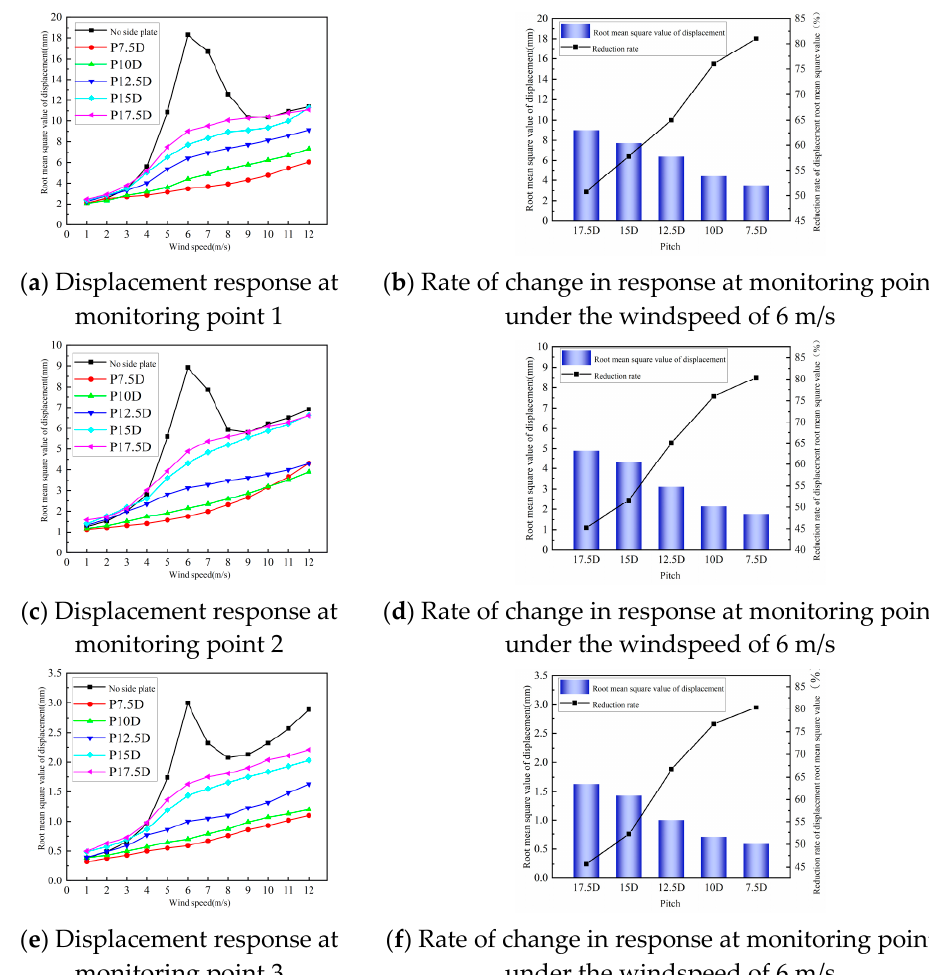
Figure 20. Root mean square value of the crosswind displacement response at the monitoring points of the high light pole structure under different pitch conditions.